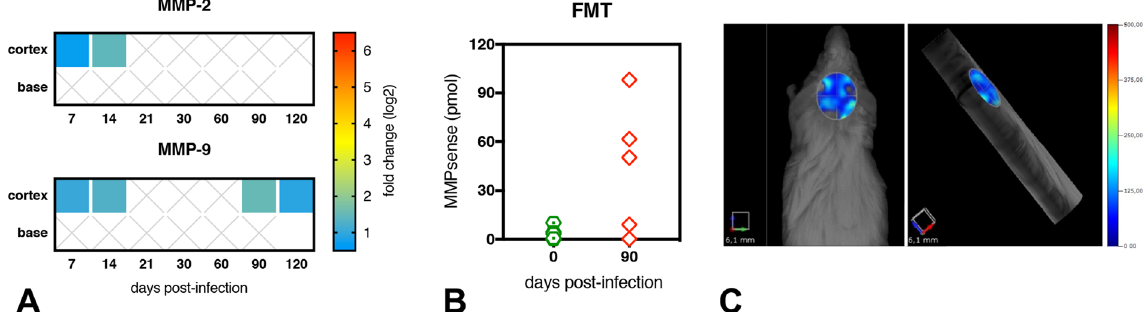
Figure 5. Transcript abundance and activity of matrix metalloproteinases (MMPs) in the brain of BALB/c mice infected with Leishmania donovani . ( A ) Relative gene expression of MMP-2 (upper panel) and MMP-9 (lower panel) in the cortex and in the base of infected mice brains. The results are expressed as fold change (up- regulation) for each time point post infection. Full-colored squares represent significant fold changes (P < 0.05). ( B ) In vivo detection of MMPs activity (including MMP-2, -3, -9 and -13) in the brain of mice at day 90 p.i. by quantitative fluorescence tomography (FMT) using the activatable fluorescent agent MMPsense 680 ® . ( C ) Tridimensional reconstruction of fluorescent tomography from a representative infected mouse exhibiting dorsal (left) and lateral (right) views, with a selected region of interest (ROI) delimitating the area of the brain, representative of 50.35 pmoles of